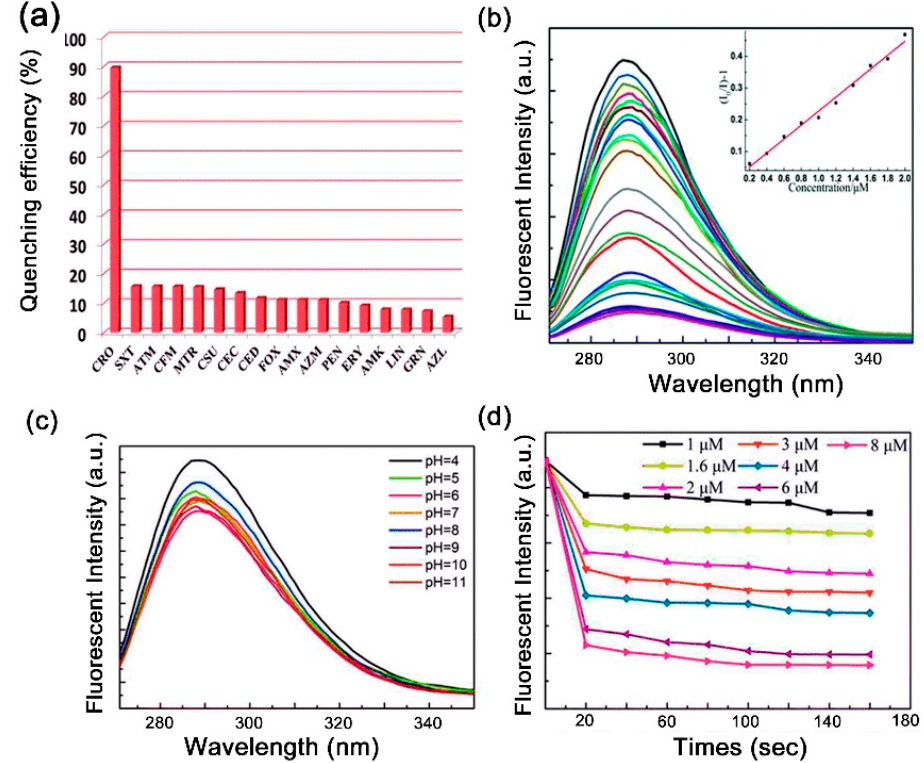
Figure 9. ( a ) Comparison of various antibiotics quenching efficiency using Cd-MOF at room temperature. ( b ) Dispersed in aqueous solution of CRO for fluorescence spectra ( c ) CRO aqueous solution tested in various pH aqueous solution using Cd-MOF, and ( d ) Fluorescence intensity of CRO solution in Cd-MOF suspensions in time dependent. Reproduced and adapted from Ref. [54]; Copyright (2019), RSC Analyst.